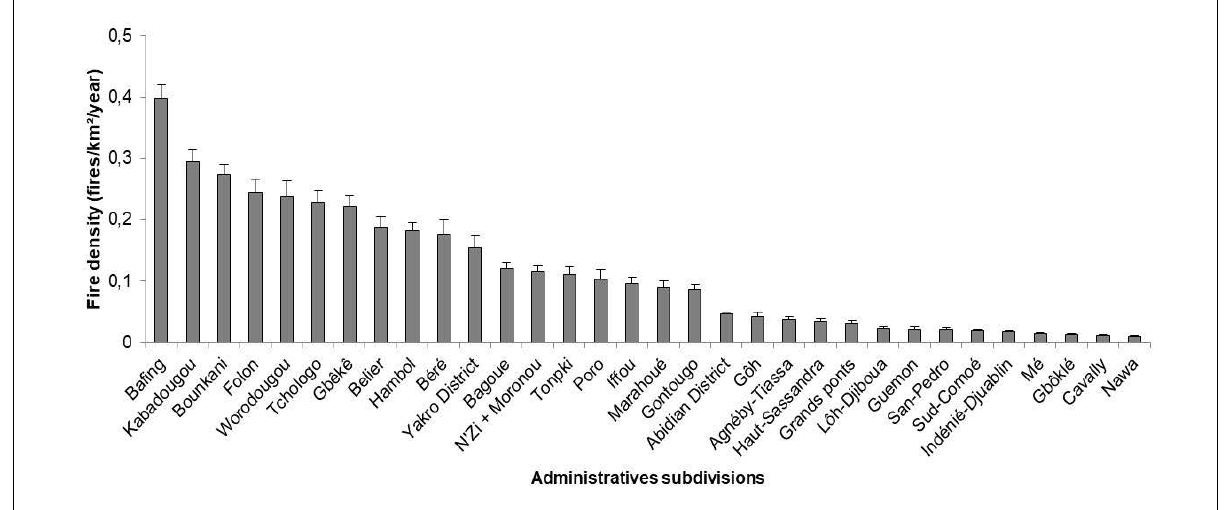
Average fire density per year in administrative subdivisions of Côte d’Ivoire over a 10-year period (2007 to 2016)